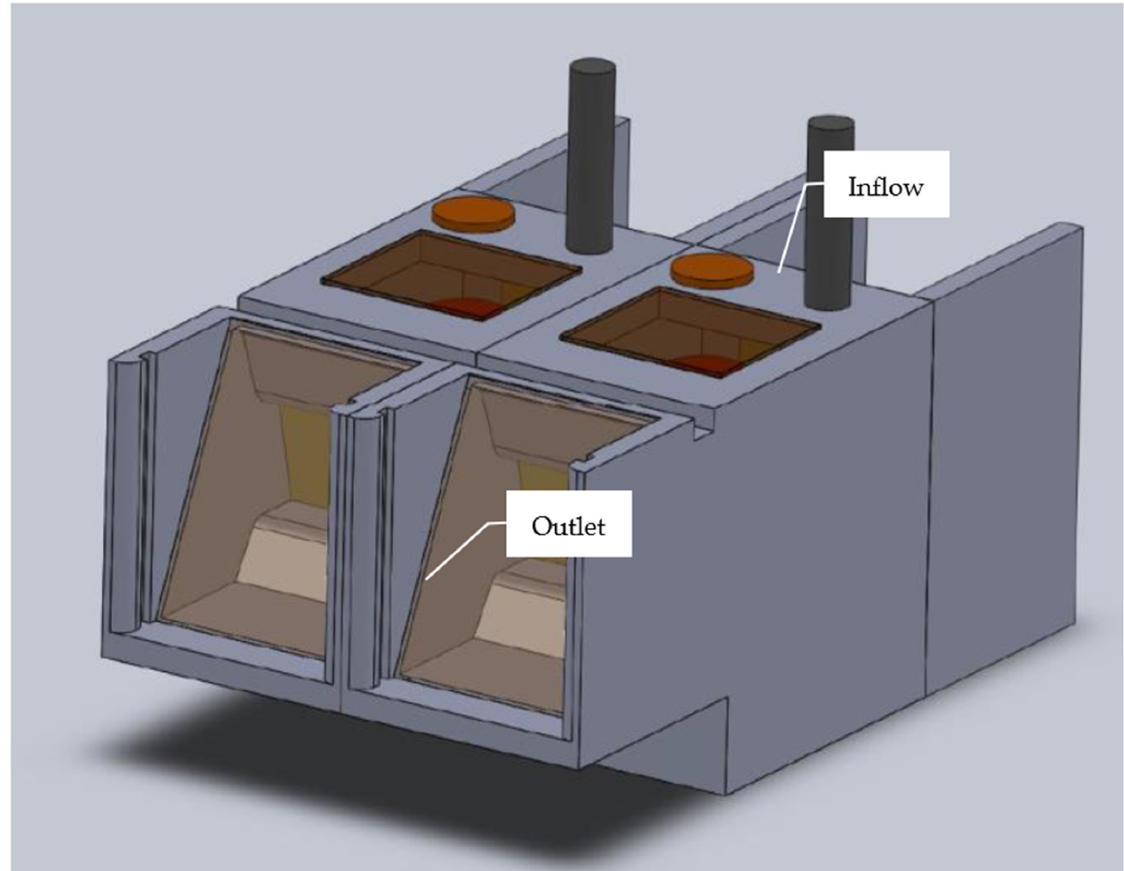
Figure 2. Modular energy chamber.